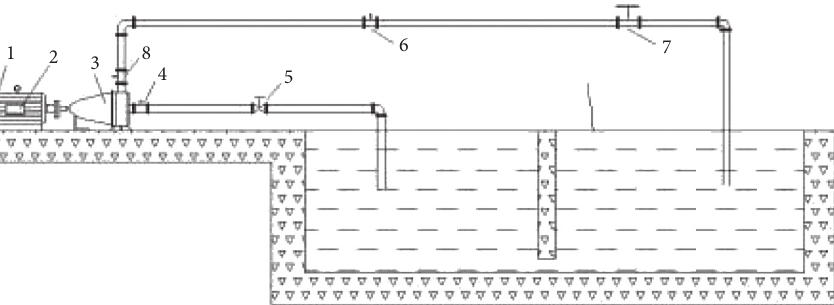
Figure 5: Experimental system. (1) Motor; (2) rotational speed meter; (3) test pump; (4) inlet pressure sensor; (5) inlet valve; (6) turbine flow meter; (7) outlet valve; (8) outlet pressure sensor.